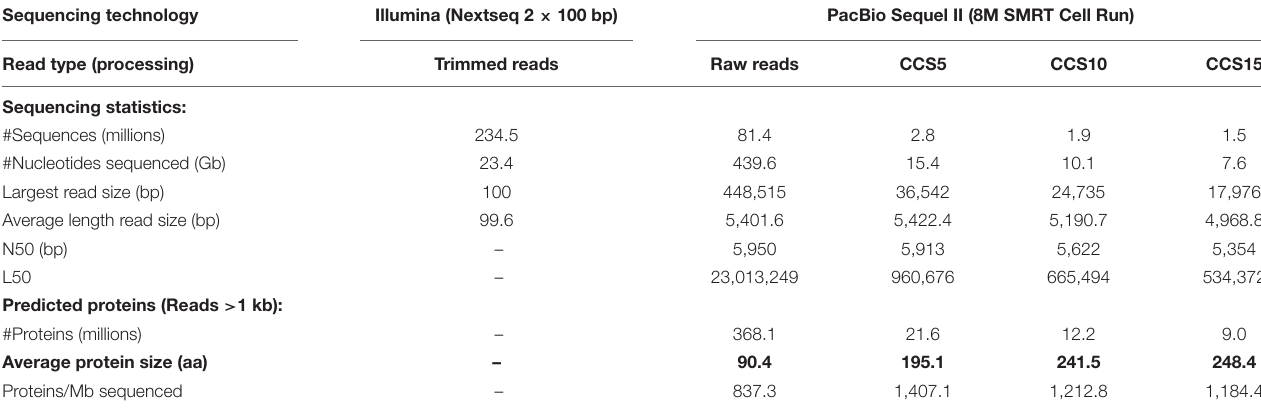
TABLE 1 | Summary statistics of the short-read and long-read sequencing technologies and protein-encoded genes retrieved from reads. Sequencing